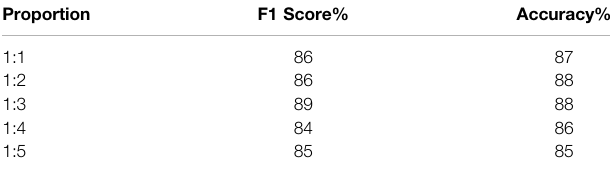
TABLE 2 | Diagnostic results of different sample proportions.